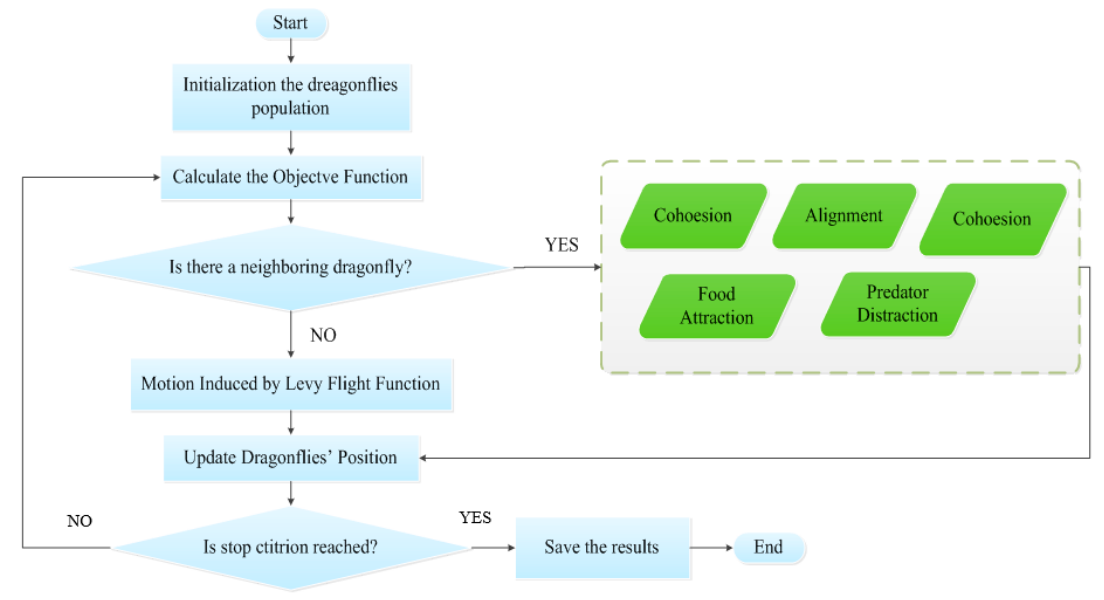
Figure 2. Flowchart of the dragonfly algorithm.